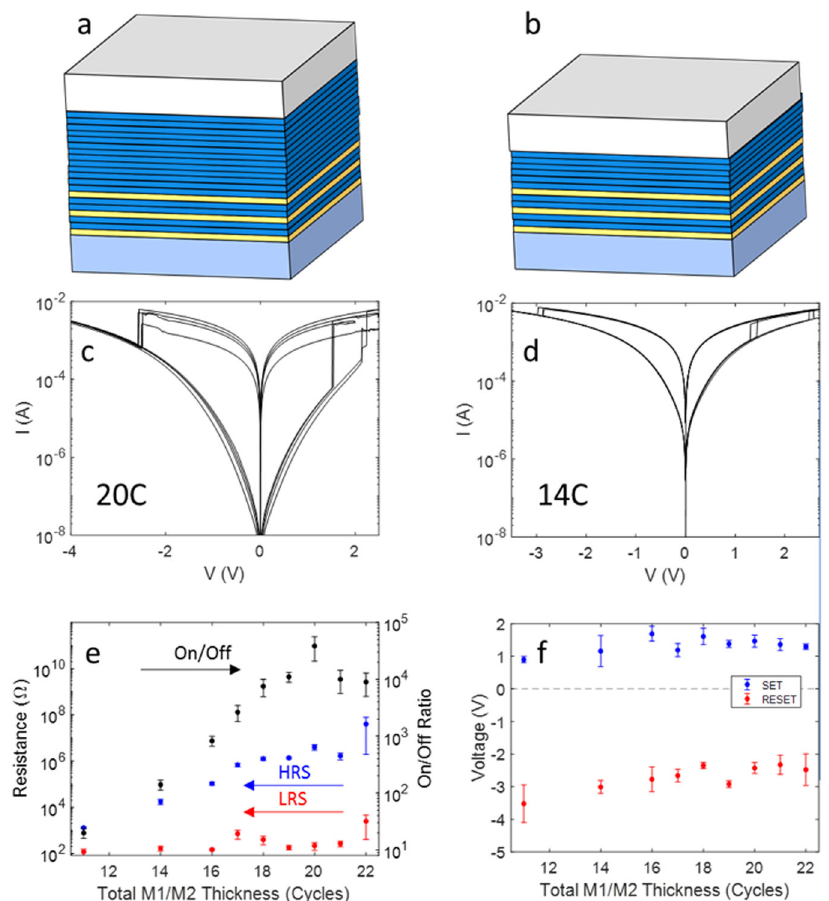
Fig. 5 Tunability of memristor properties by M1/M2 thickness. Diagrams of memristors with an M2 layer of 1 C MgO (~0.11 nm thick) structure with total M1(oxide)/M2(defective oxide) layer thickness of a 20 C, and b 14 C, respectively. Five repeated current/voltage ( IV ) sweeps of c a 20 C, and d a 14 C memristor. e High resistance state (blue), low resistance state (red), and on/off ratio (black) values along with f SET and RESET voltages as a function of the atomic layer numbers in M1/M2 stack with the similar architecture shown in Fig. 5a, b. Error bars in e were produced from the standard error of multiple device measurements. Error in the SET/RESET voltages of f were a result of the weighted standard deviation of SET/RESET voltages across multiple